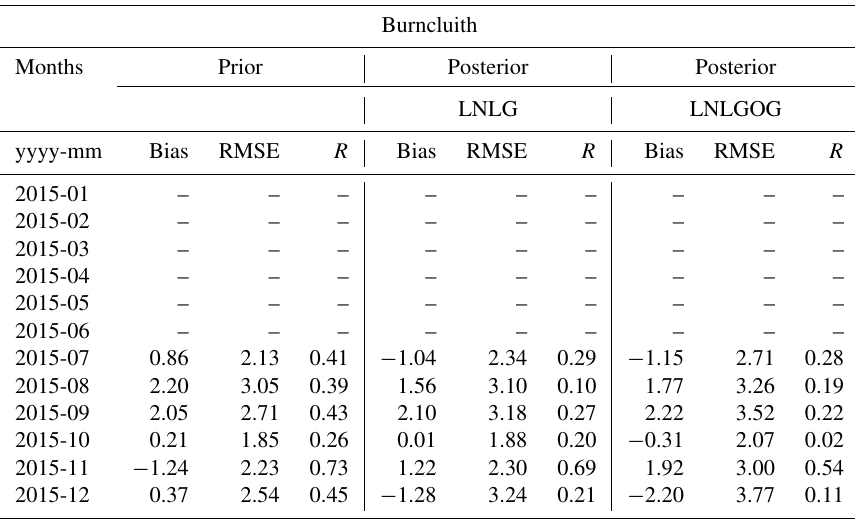
Table H3. Analysis of the residual between CMAQ prior and posterior simulations and the Burncluith site for 2015: averaged bias, RMSE and Pearson’s coefficient ( R